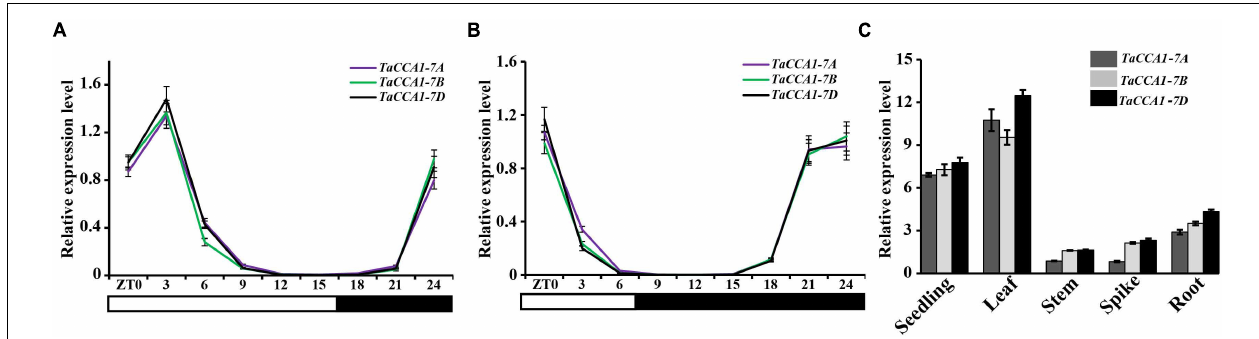
FIGURE 1 | Temporal and spatial expression of TaCCA1 homoeologs. (A,B) qPCR analysis of relative expression levels of TaCCA1-7A , TaCCA1-7B , and TaCCA1-7D every 3 h in a 24-h period (light/dark cycle is shown below the histogram) in hexaploid wheat 73064-1 under short- (A) and long-day (B) conditions. (C) qPCR analysis of TaCCA1 homoeologs relative expression levels in the seedling, leaf, stem, panicle, and root. Leaf, stem, panicle, and root are from booting stage wheat plants (line 73064-1) at ZT3. Values are means ± SD ( n = 3).